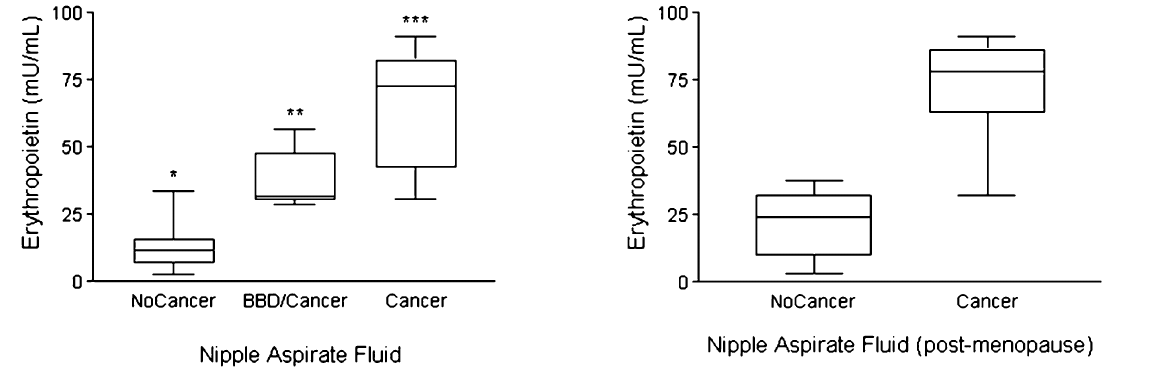
Fig. 1. Median levels of erythropoietin (Epo) in NAF from NoCancer women ( N = 88), patients affected by Cancer ( N = 21), and pa- tients originally diagnosed with benign breast diseases who subse- quently developed breast cancer (BBD/Ca, N = 7). ( ∗ = NoCancer vs. Cancer , P < 0 . 0001; ∗∗ = BBD/Ca vs. Cancer , P = 0 . 004; ∗∗∗ = BBD/Ca vs. NoCancer , P < 0 . 0001.)